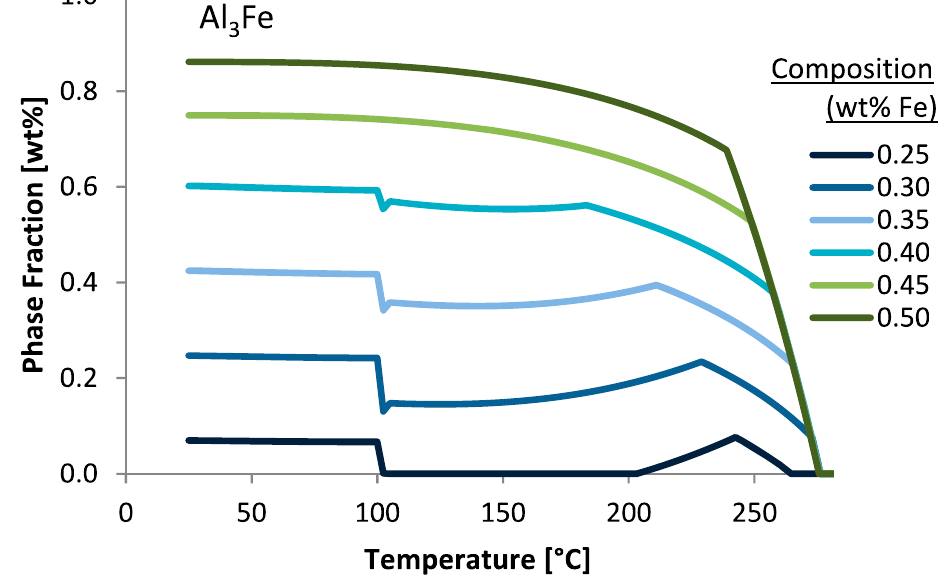
Figure 2. Variation of the predicted equilibrium for the Al 3 Fe phase in Al 6061 with a content variation of the alloying element iron, as a function of temperature, between room temperature and more than 250 °C.